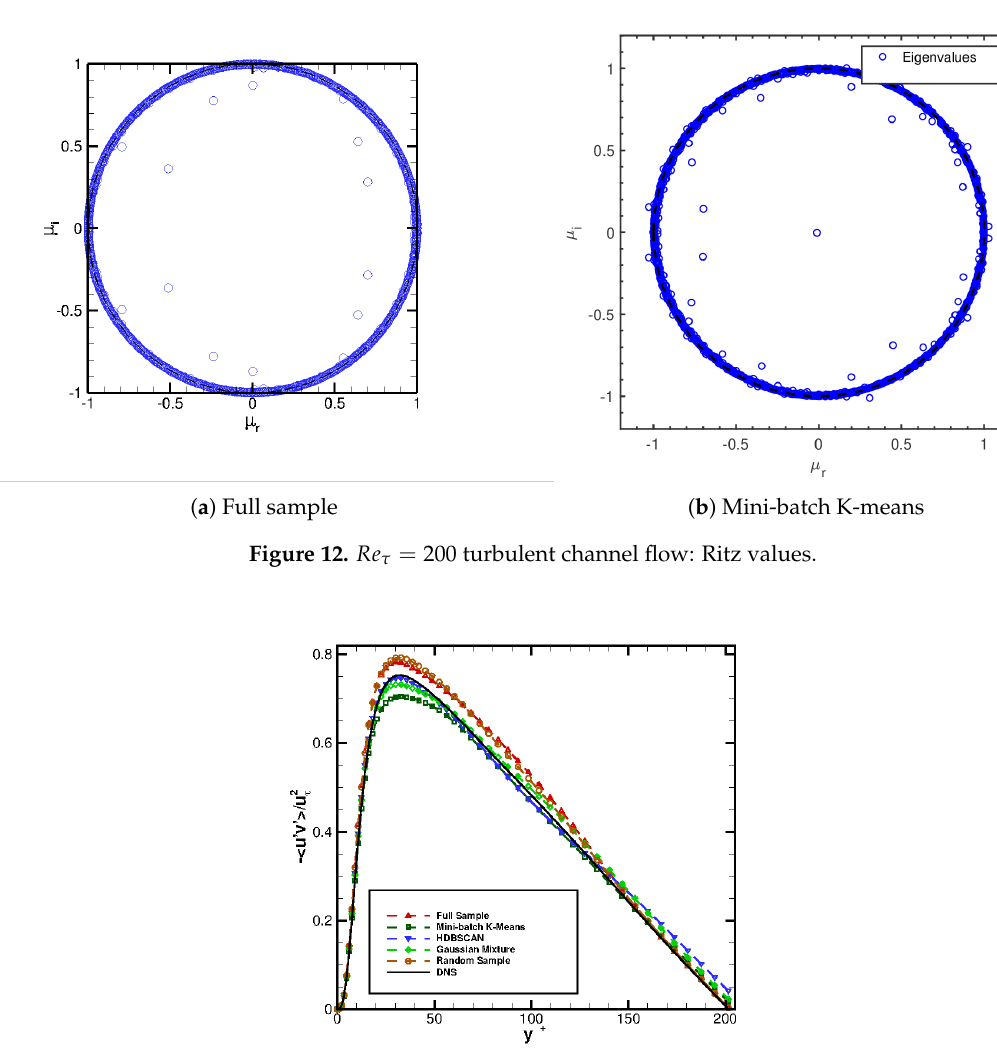
Figure 13. Re τ = 200 turbulent channel flow: DMD reconstruction of the Reynolds stress profile − (cid:104) u (cid:48) v (cid:48) (cid:105) ( y + ) using in Equations (6) and u 2 τ